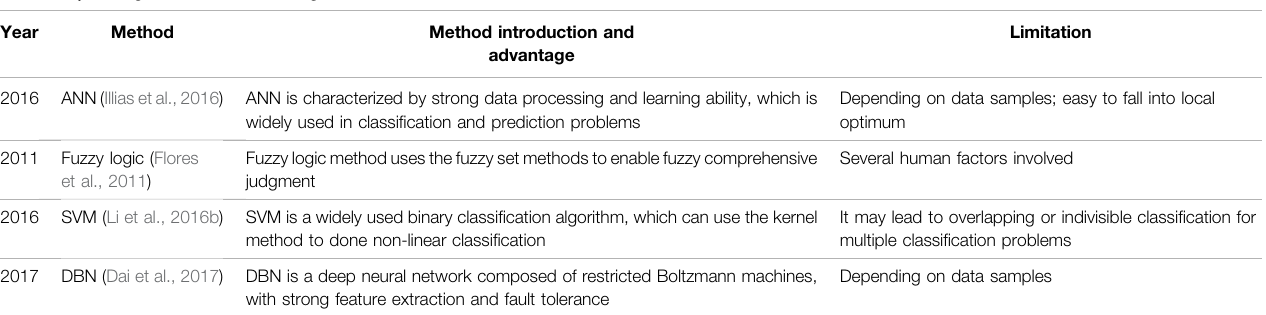
TABLE 2 | Investigations of arti fi cial intelligence